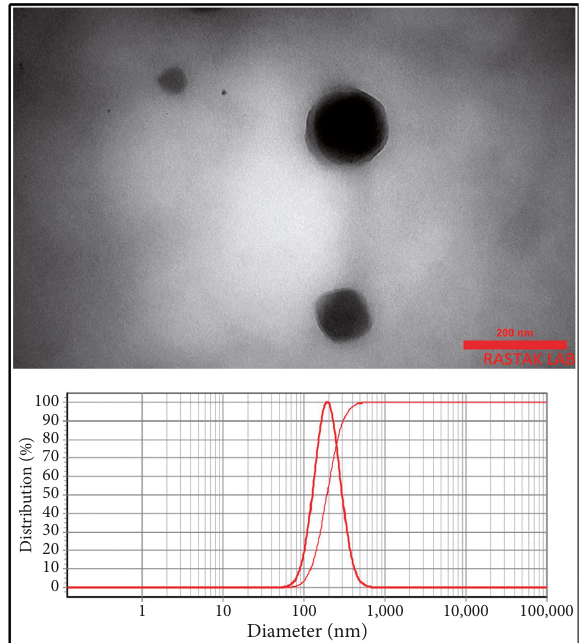
Figure 3: TEM and DLS analyses of nanoliposomes containing the 2.5% C. zeylanicum EO with a particle size of 195 ± 9nm (SPAN